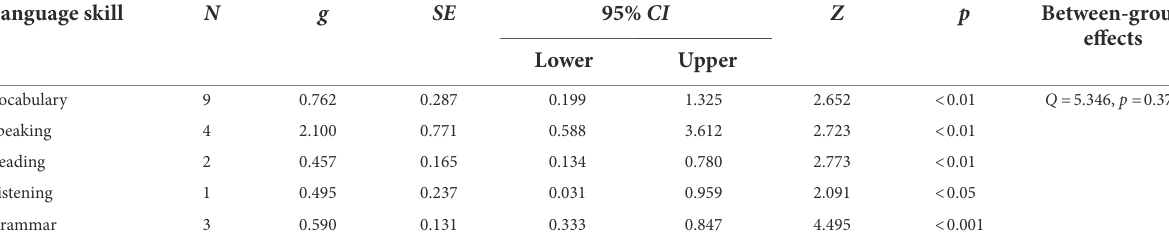
TABLE 5 Impacts of XR on the learning effects, by language skill. Language